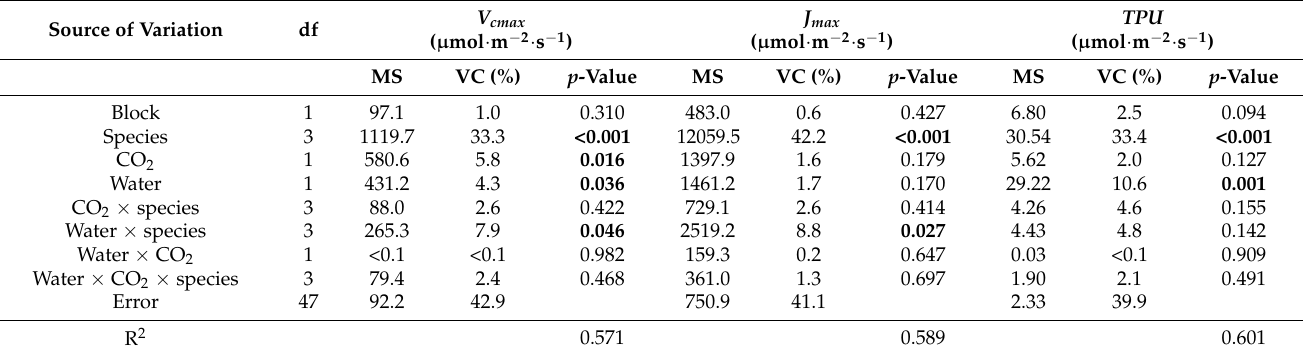
Table 2. Assimilation to internal CO 2 traits and ANOVAs from the CO 2 × moisture stress treatment experiment, 2017, including source of variation, degrees of freedom (df), mean square values (MS), variance components (VC), p -values, and coefficient of determination (R 2 ). p -values < 0.05 are in bold